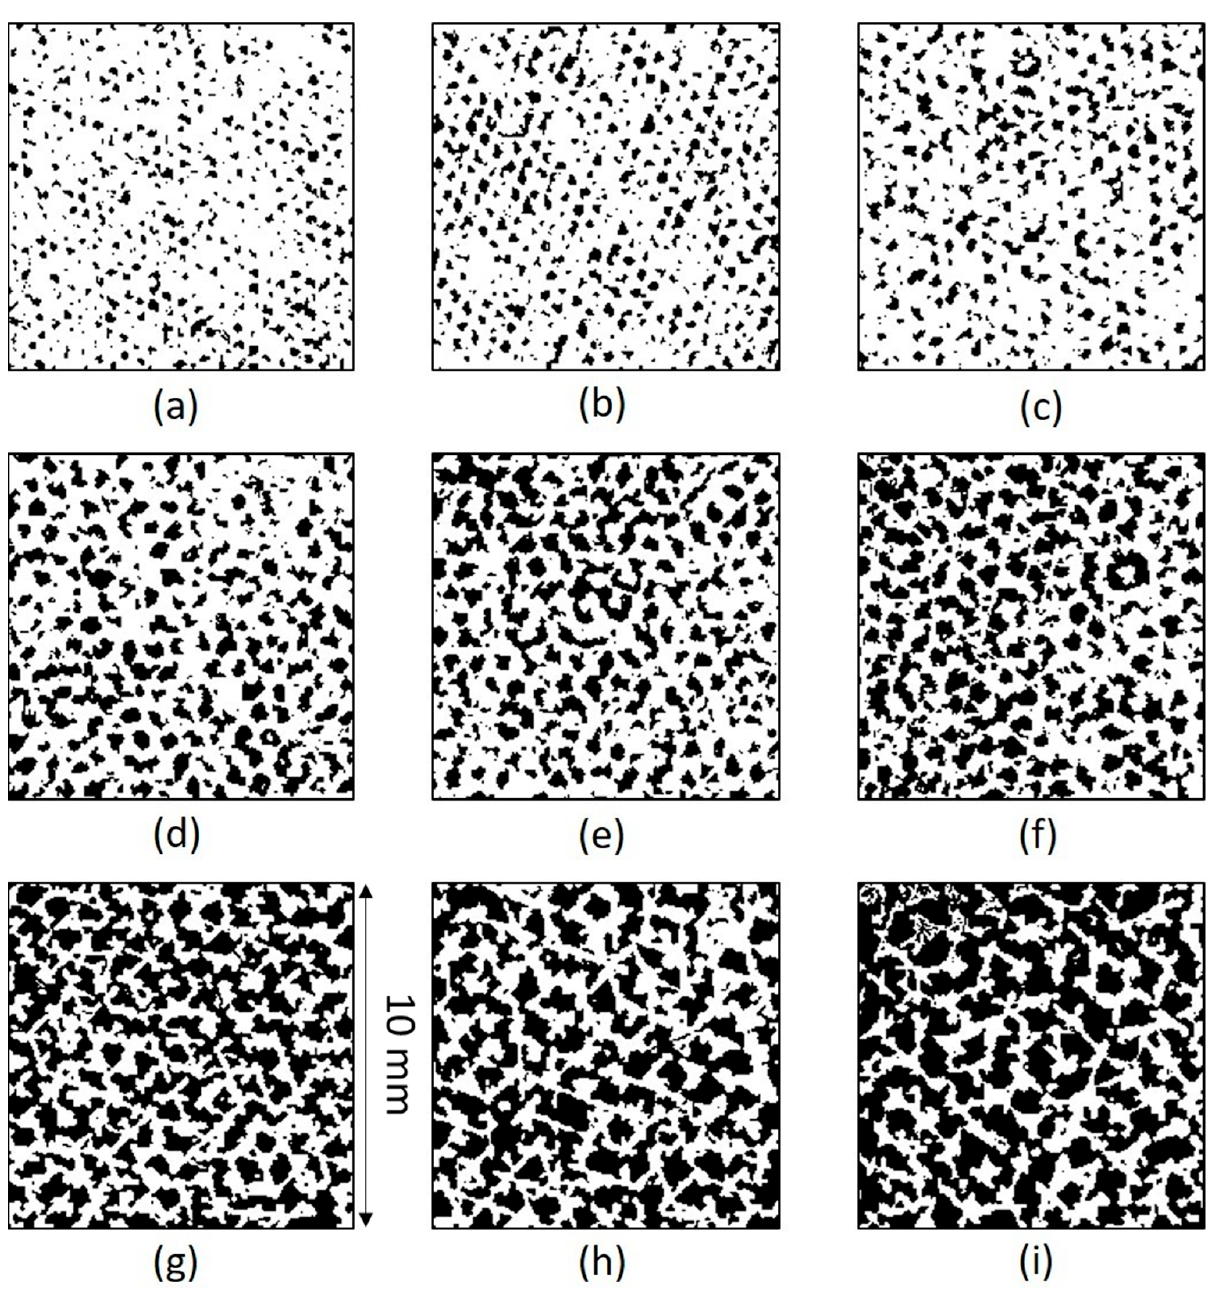
Figure 6. Binary image showing projected pores (black parts) by surface grinding the ( a ) D1, ( b ) D2, ( c ) D3, ( d ) D4, ( e ) D5, ( f ) D6, ( g ) D7, ( h ) D8, and ( i ) D9 samples, respectively. (The width and length of each image corresponds to the surface area of 10 mm × 10 mm).